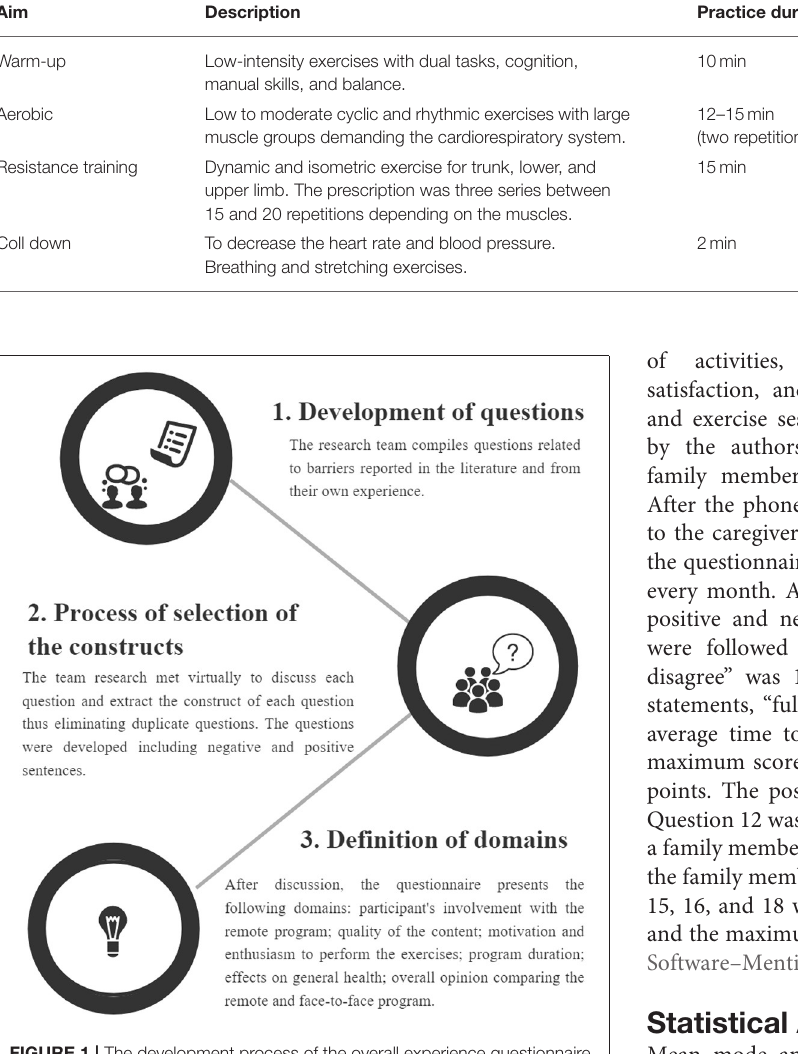
FIGURE 1 | The development process of the overall experience